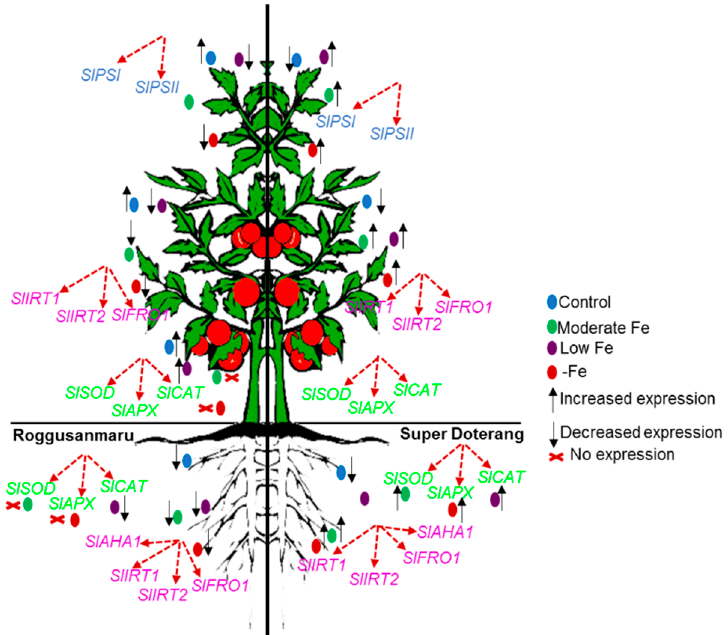
Figure 10. Diagrammatic representation of the present study for the regulation and uptake of Fe in selected tomato cultivars (Roggusanmaru and Super Doterang). Expression of Fe transport and Fe(III) chelate related genes, as well as antioxidant mechanism is represented. Upper arrows represent increased fold change, lower arrows represent lower fold change and cross represents no fold changes.